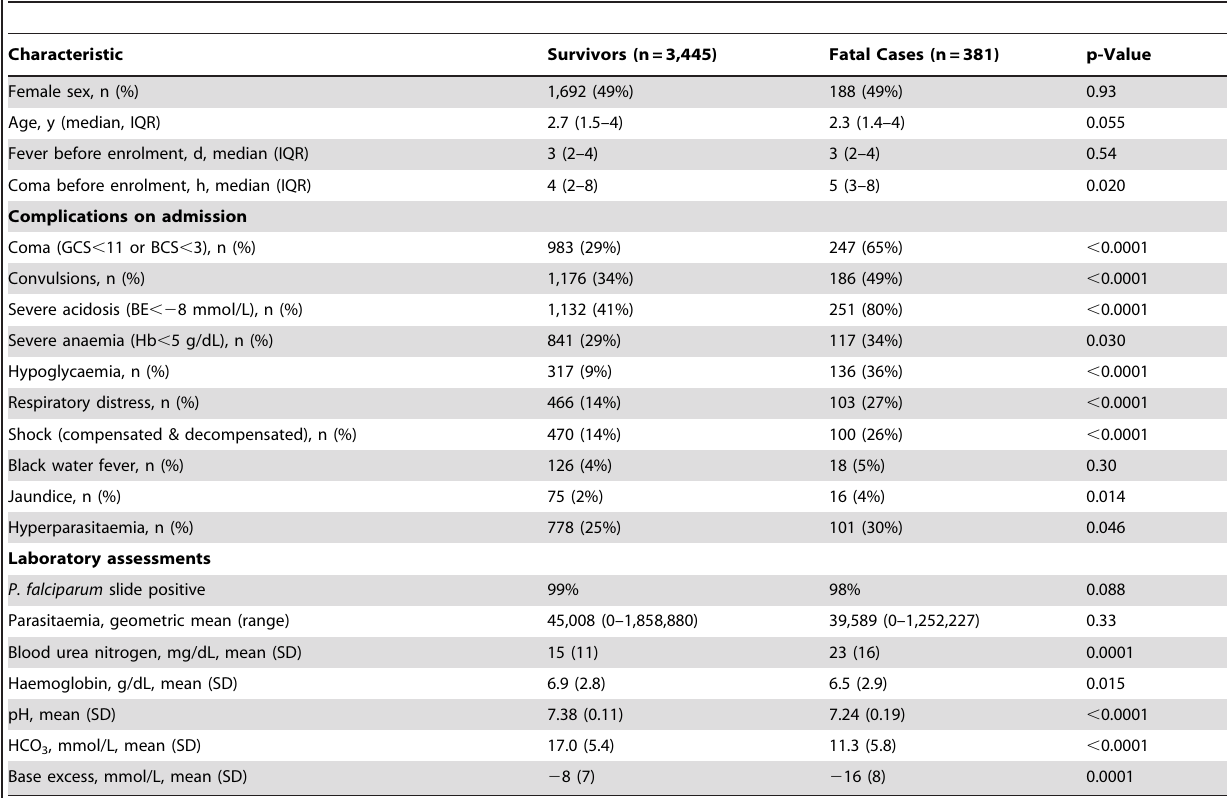
Table 1. Demographic, clinical, and laboratory characteristics of children diagnosed with severe falciparum malaria according to